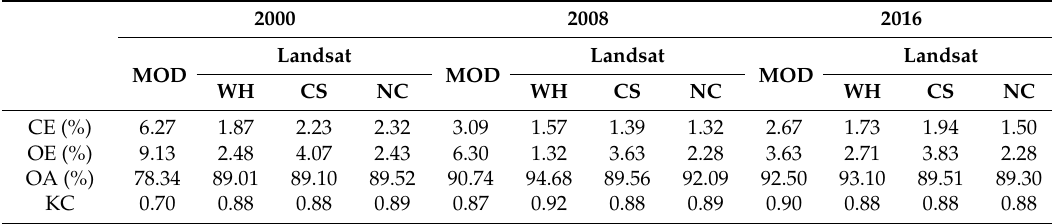
Table 2. Results of the commission error, omission error, overall accuracy, and kappa coefficient for assessing the urban category in each image (MOD: MODIS; WH: Wuhan; CS: Changsha; NC: Nanchang).